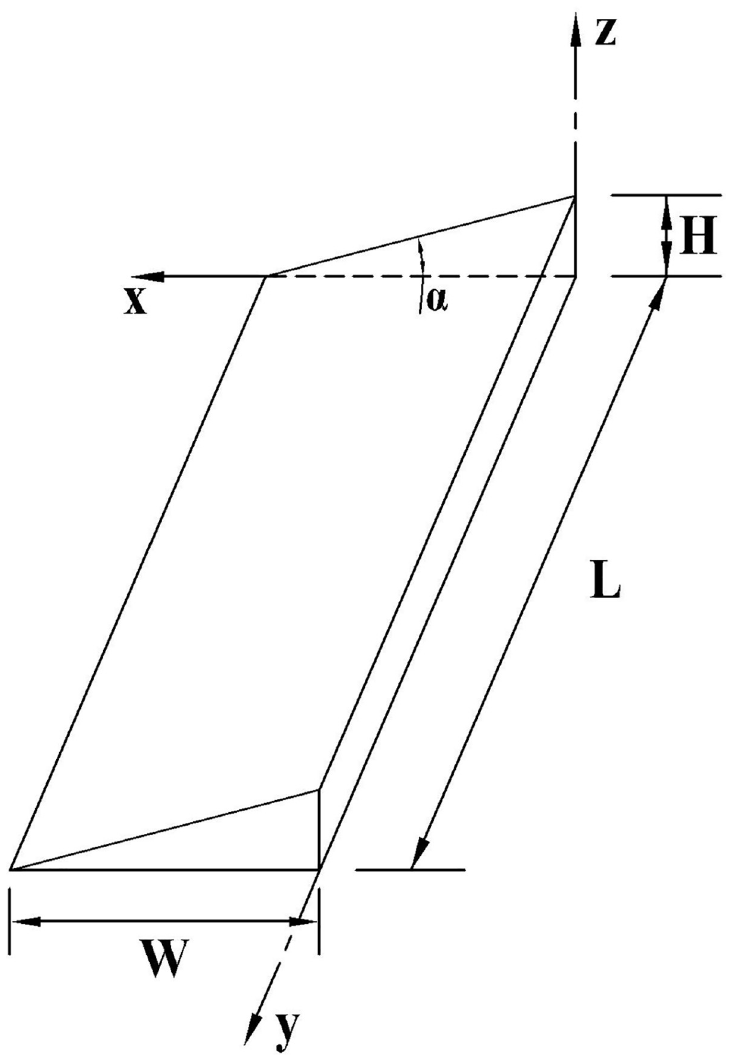
Fig 6. Road surface water accumulation Model